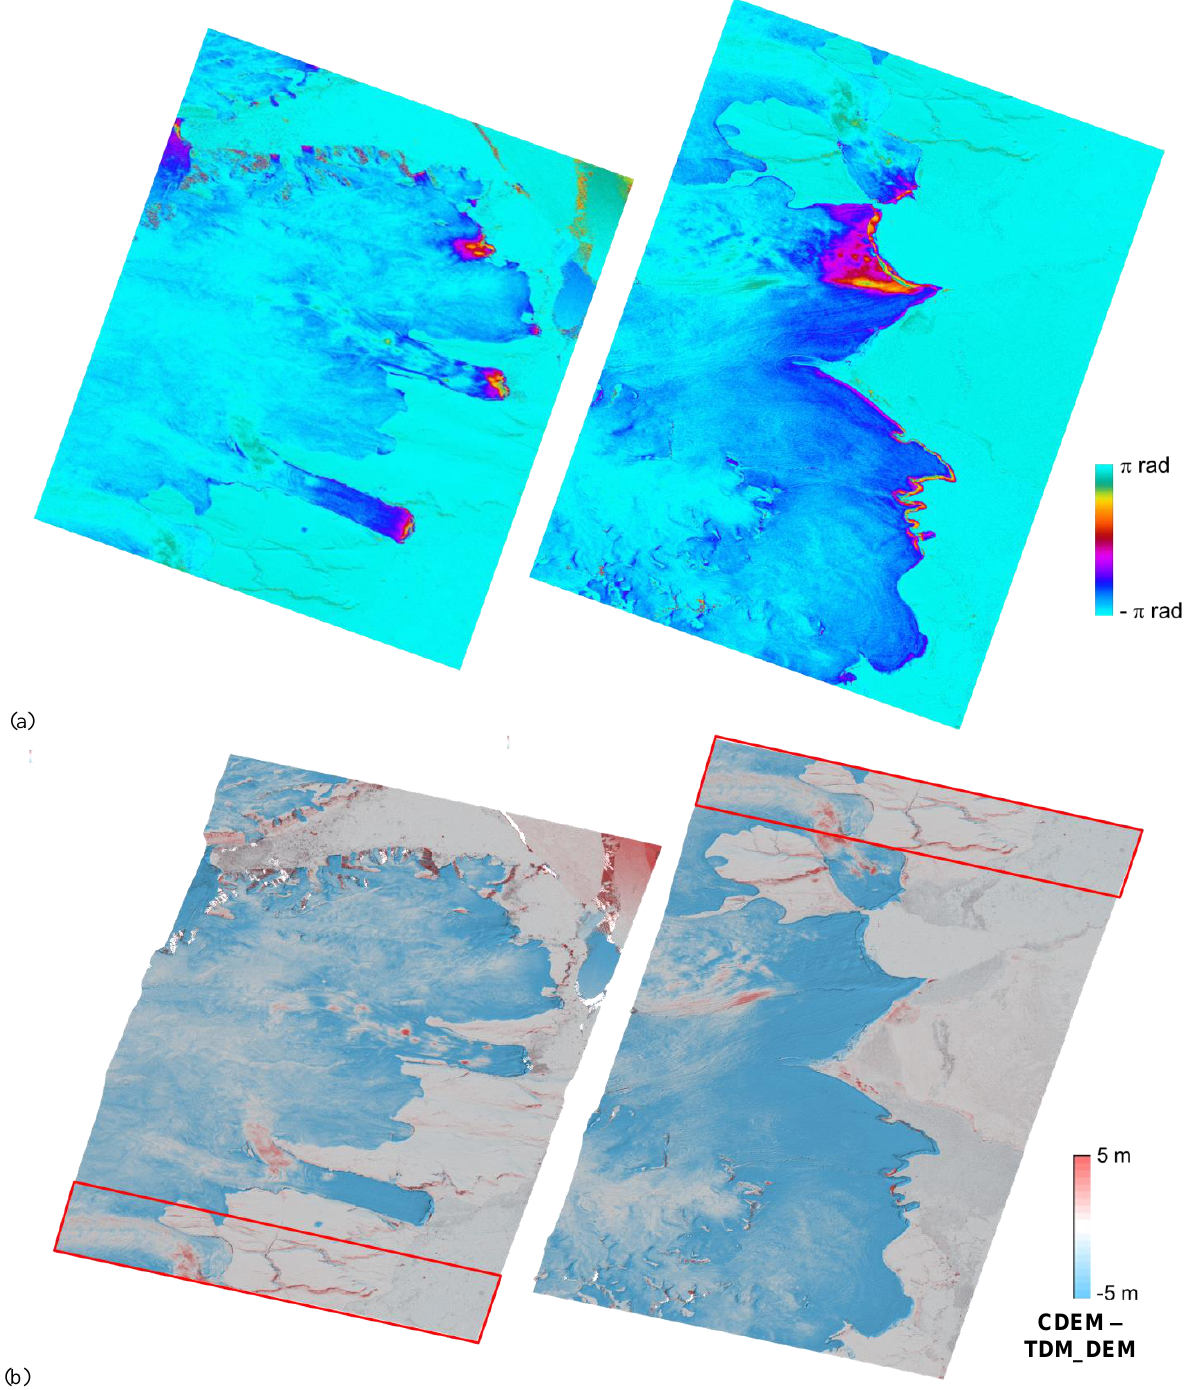
Figure 3. Two scenes from the same datatake acquired on 02/11/2017 over the east coast of Devon Island (HoA=40 m/cycle). (a) interferometric phases flattened with an edited TanDEM-X DEM; (b) height differences between the new acquisition and the edited reference TanDEM-X